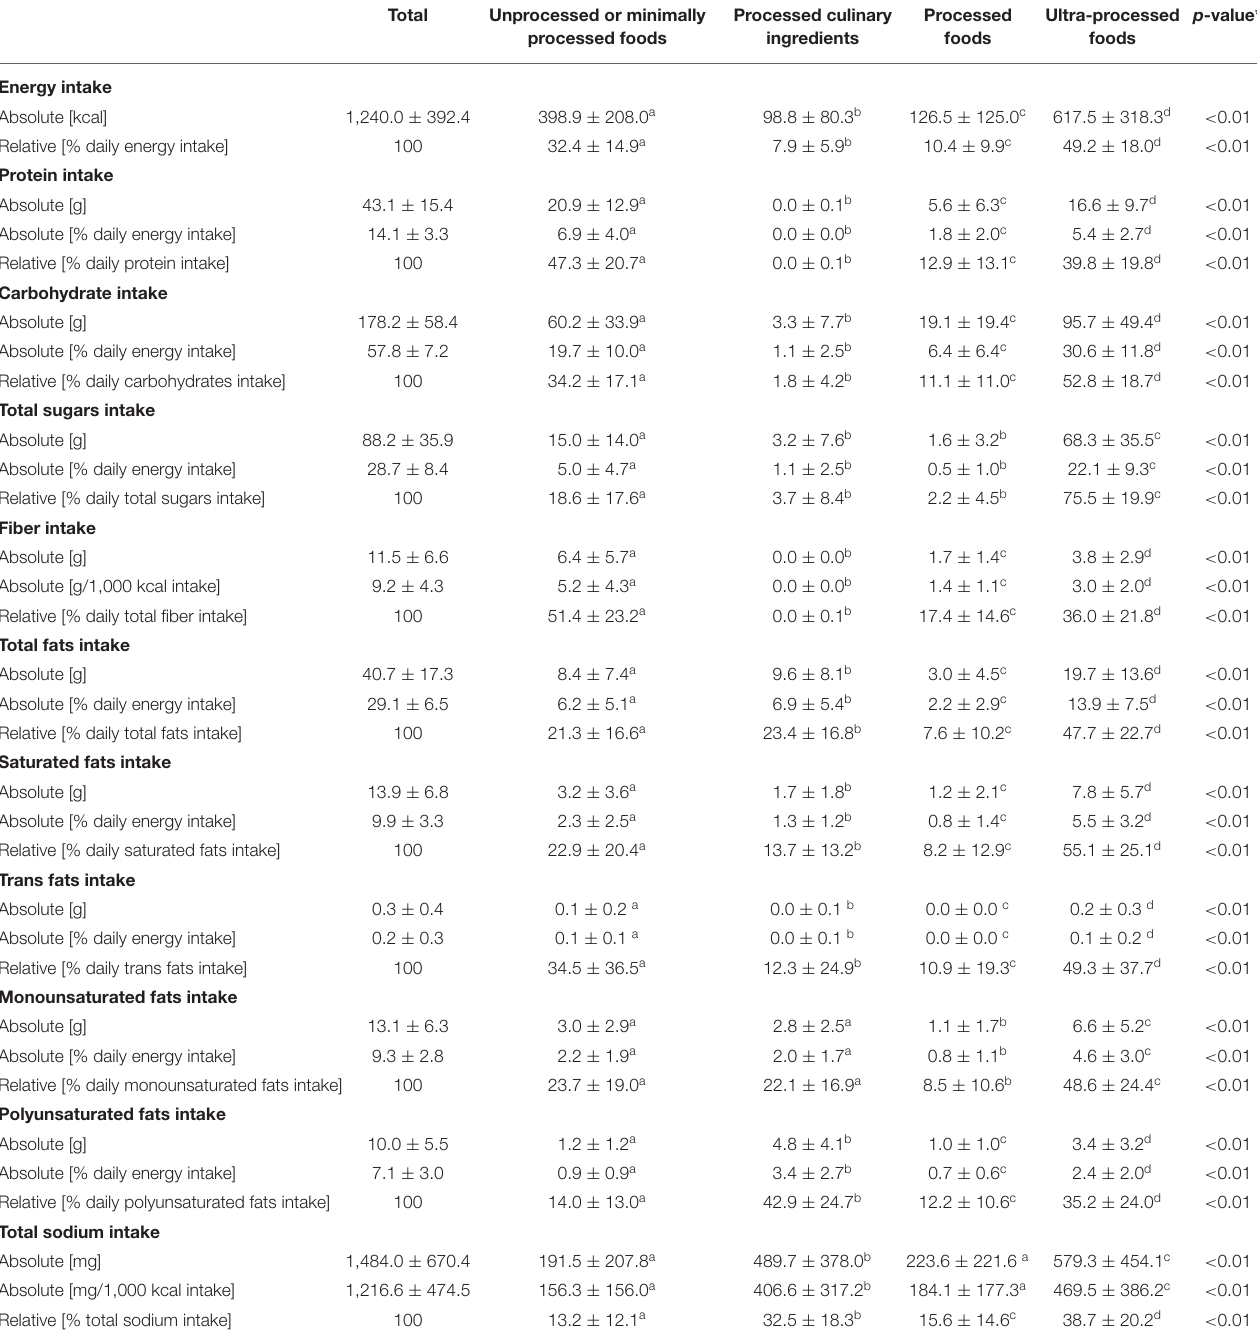
TABLE 2 | Intake of energy and nutrients of concern by the participants ( n =